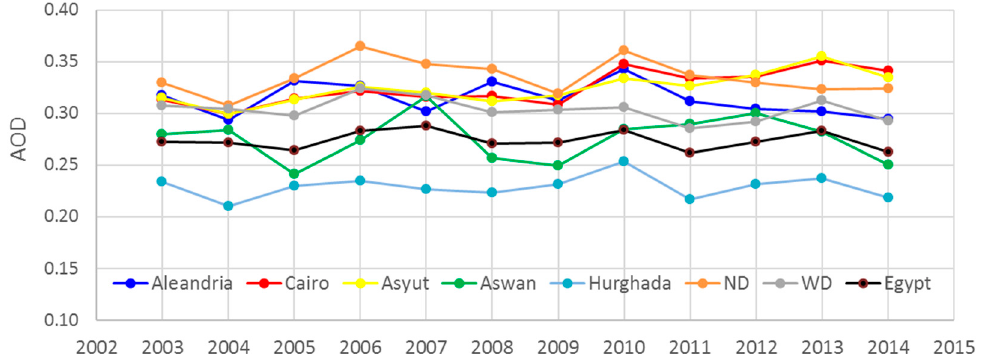
Figure 14. Annual average AOD from 2003–2012) over the selected cities, regions, and Egypt. Data over the cities are obtained from 50 × 50 km 2 around the center.